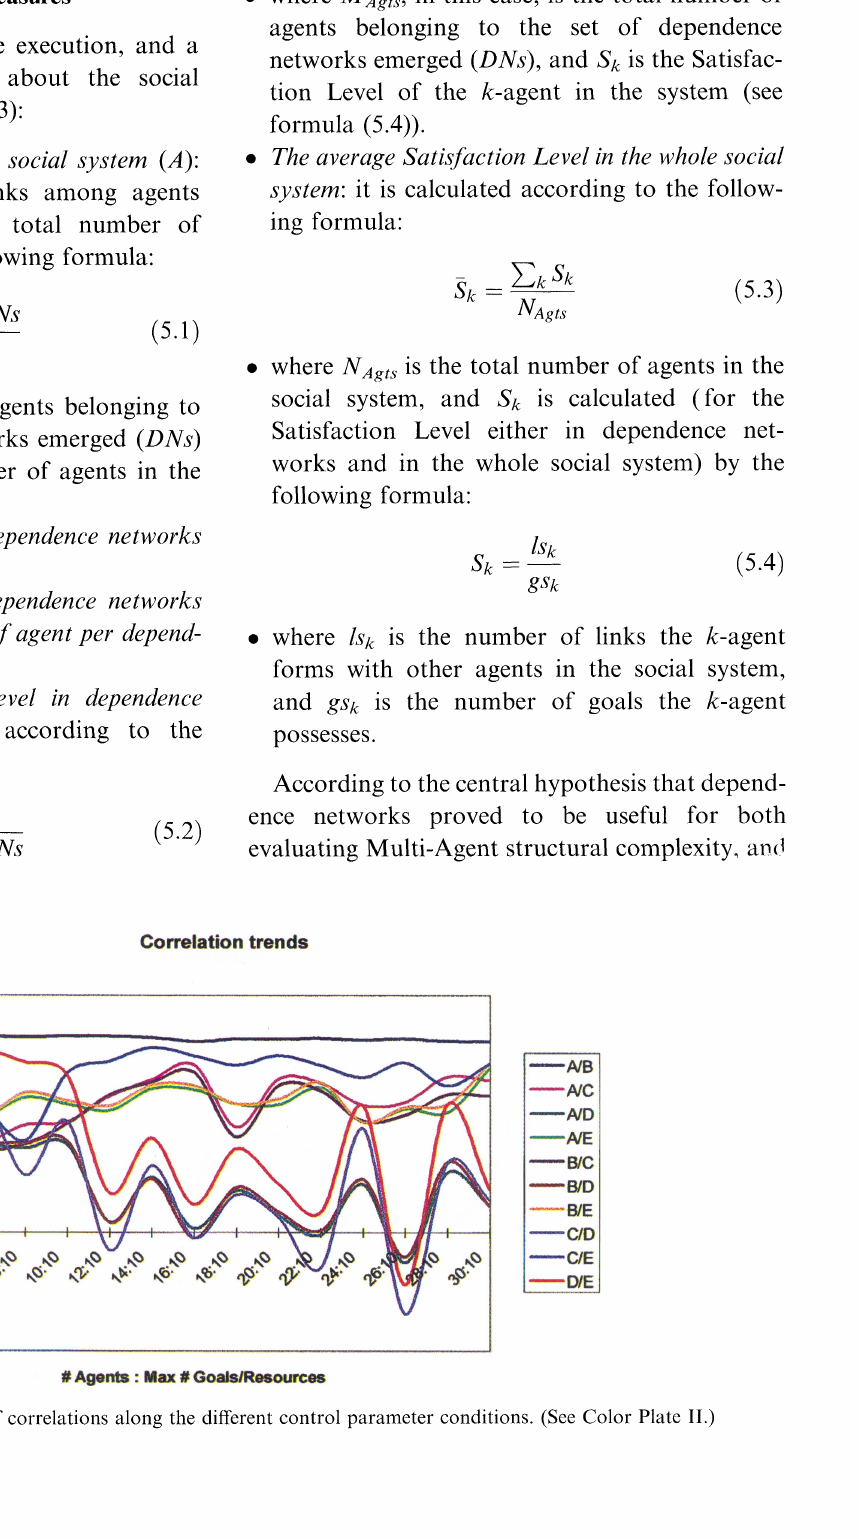
FIGURE 3 The dynamics of correlations along the different control parameter conditions. (See Color Plate